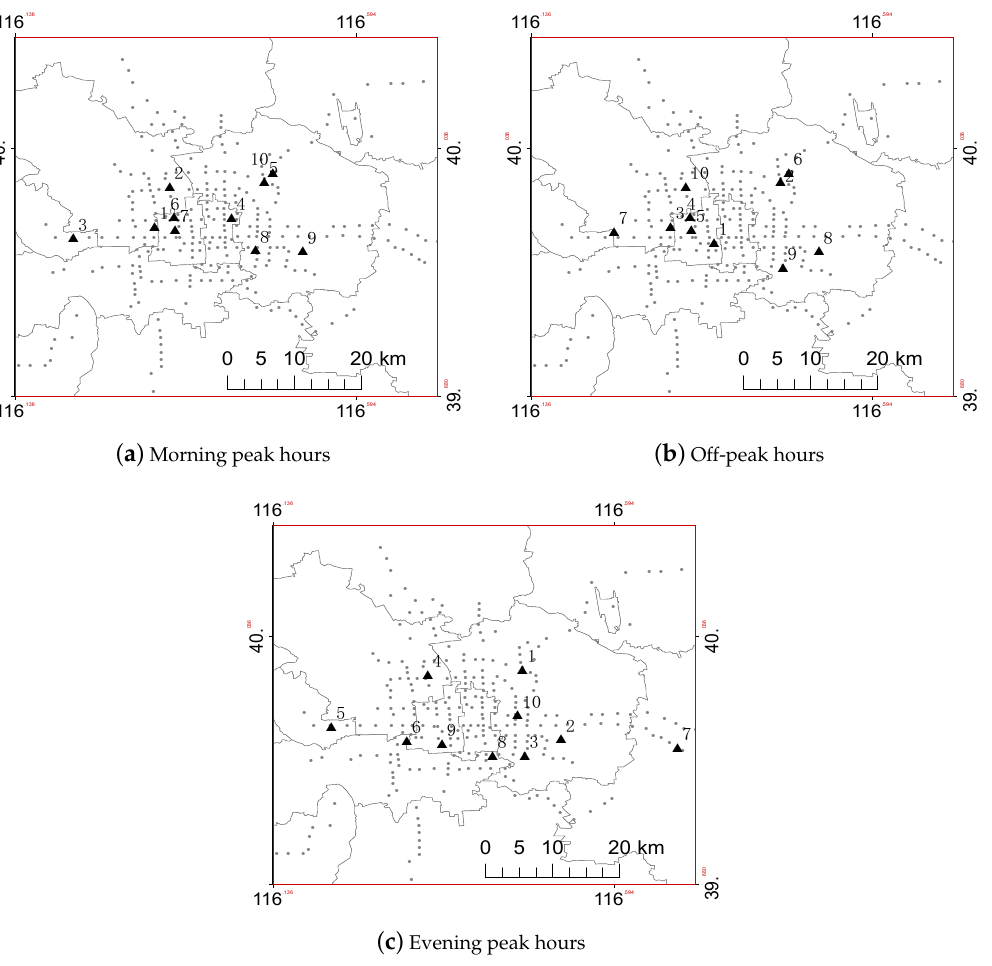
Figure 8. Locations of most vulnerable ambulance stations.